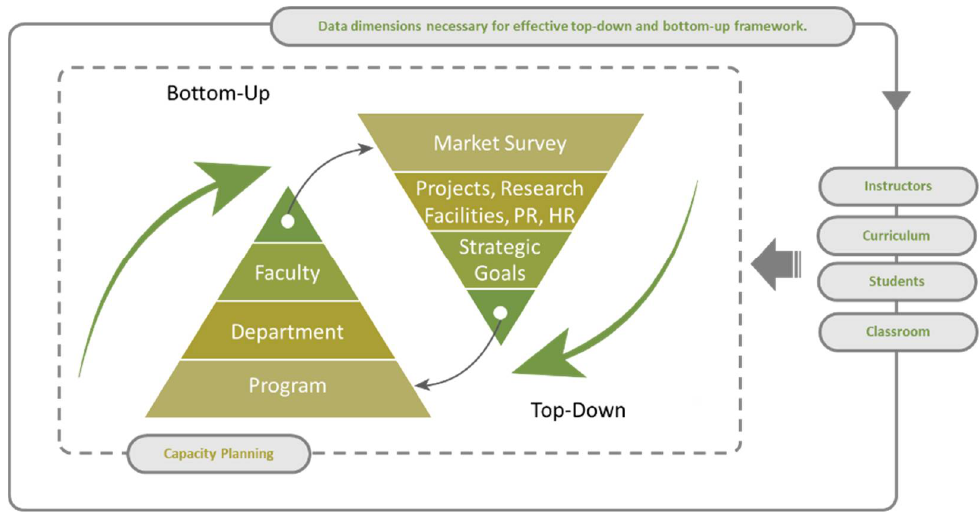
Figure 2. The proposed bottom-up and top-down framework of university student enrollment ca- pacity